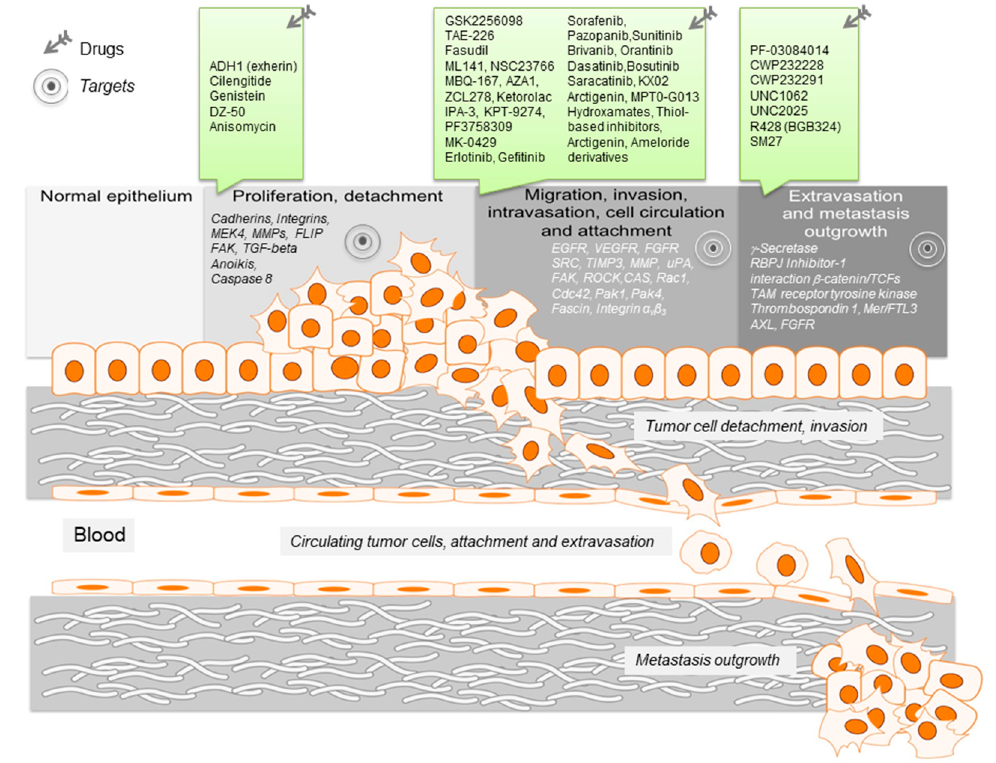
Figure 1. Schematic representation of the key events leading to metastasis. For the different metastatic steps important genes are listed, which represent drivers of the metastatic process. They enable cancer cell migration, invasion intra- and extravasation as well as metastasis outgrowth. Such genes represent promising targets for therapeutic interventions. In this regard, small molecule inhibitors are listed, which target particular steps in the metastatic process.